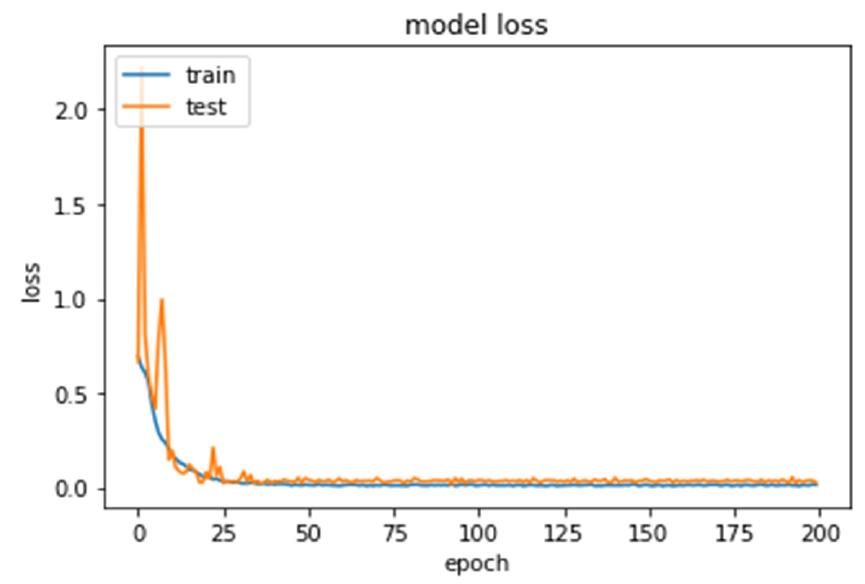
Figure 6. Model’s training and test accuracy over epochs with RMSprop and ReLU.